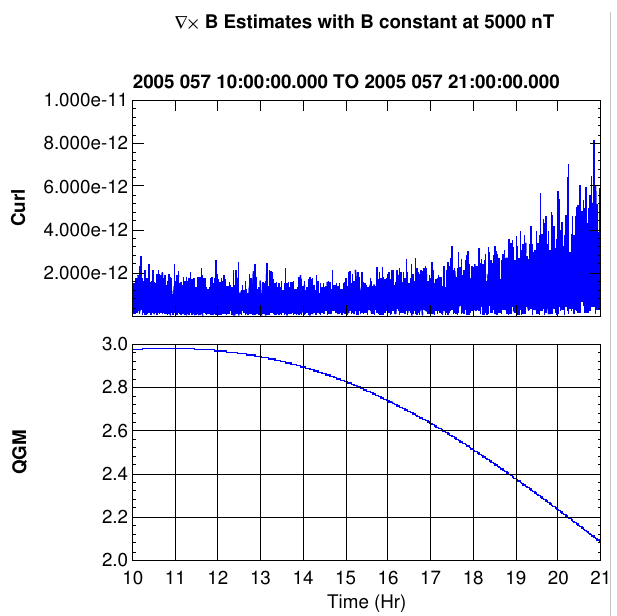
Fig. 3. Variation in the estimated curl due to variations in the Cluster configuration.